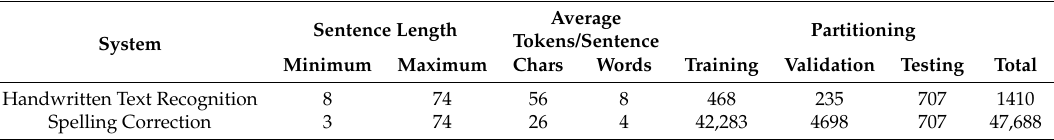
Table 4. Data distribution from Saint Gall database.